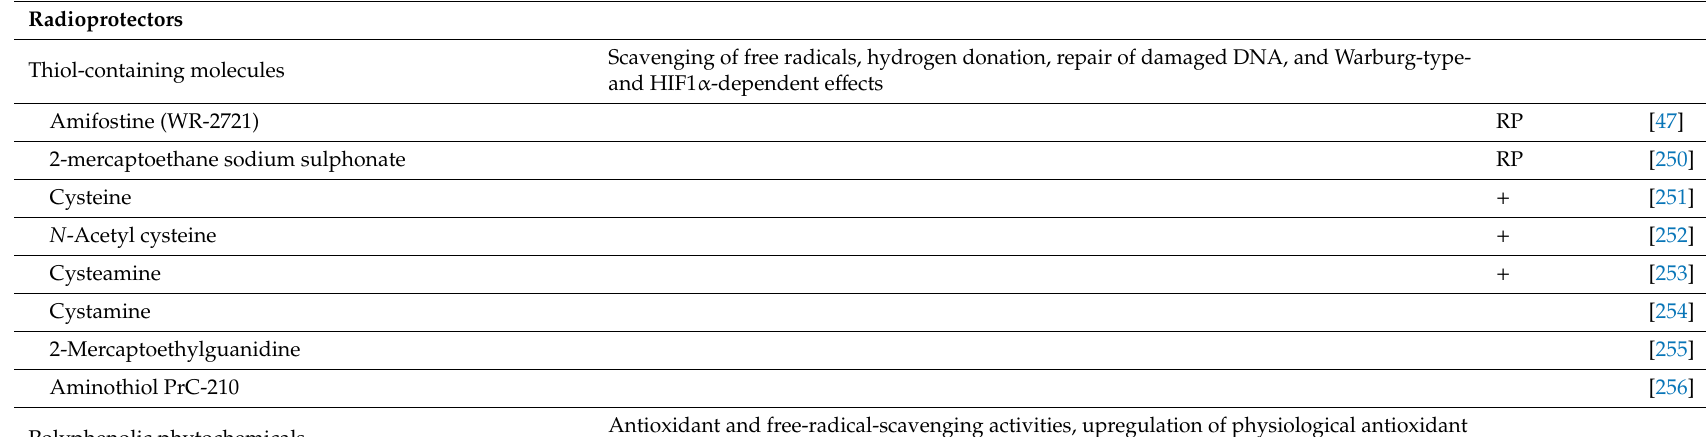
Table 1. Radioprotectors and radiomitigators tested in vivo and their radiomodifying mechanisms. Compounds are listed according to their main mechanism, although some have protecting and mitigating properties. Approval ( + ) means that a specific compound has been approved or is under clinical trials for use in humans in at least one medical indication. In this, we searched at www.fda.gov and www.clinicaltrials.gov. Only compounds marked as RP (radioprotector) or RM (radiomitigator) have been approved or a recognized as an investigational new drug for those specific uses. Due to the abundant literature, references included in this table only intend to be a representative example to lead the reader to a more extensive literature.